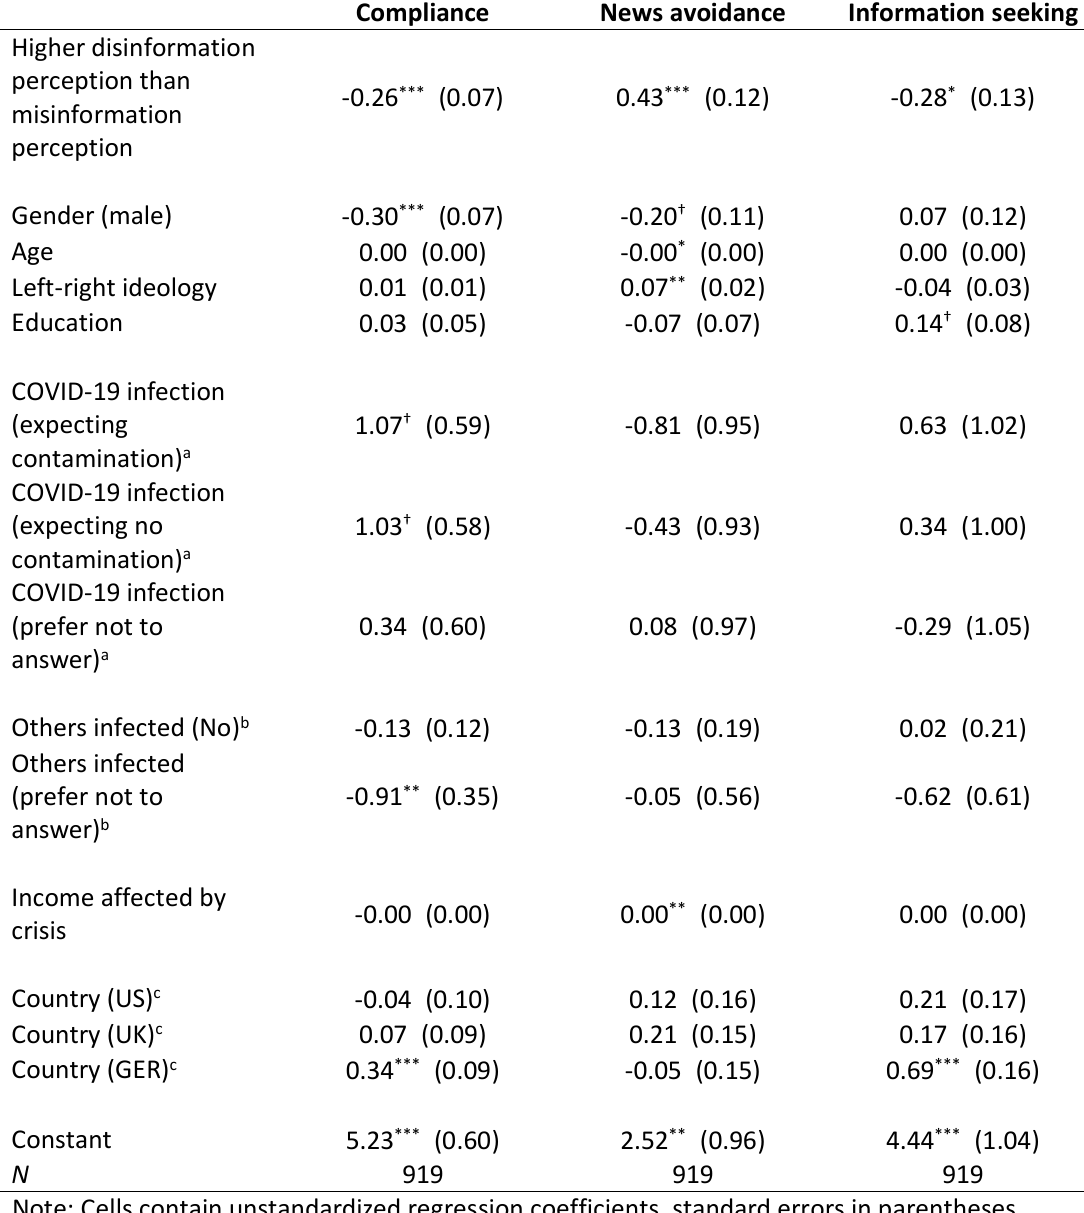
Table C1 . Willingness to comply, news avoidance, and intentional exposure predicted by